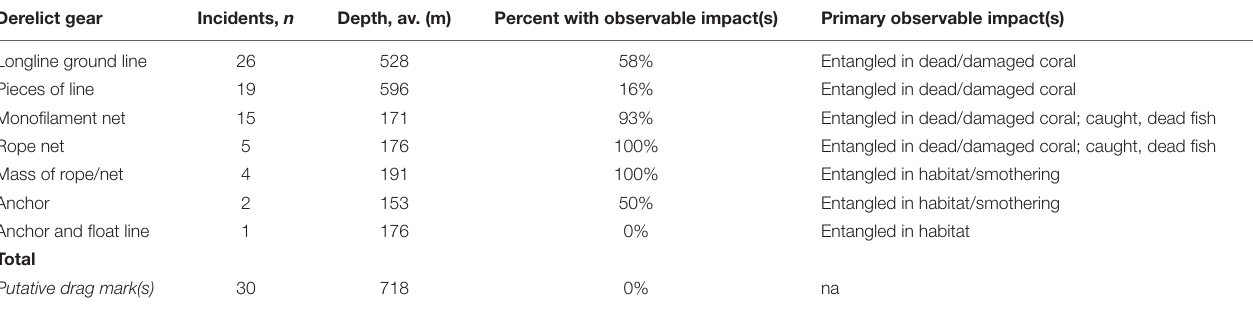
TABLE 2 | Documentation of derelict fishing gear (DFG) abandoned, lost, or otherwise discarded, and observable impacts during 2012 visual survey. Derelict